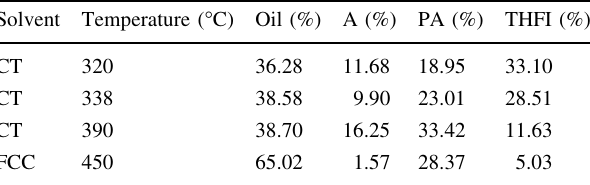
Table 5 The extraction results of liquid–solid products (liquid–solid products basis)